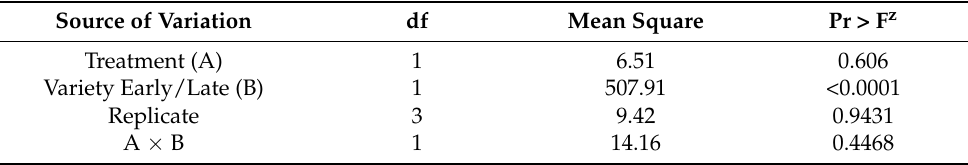
Table 2. Summary of analysis of variance of brown rot incidence recorded in the field at harvest time among 38 trials conducted during 6 seasons